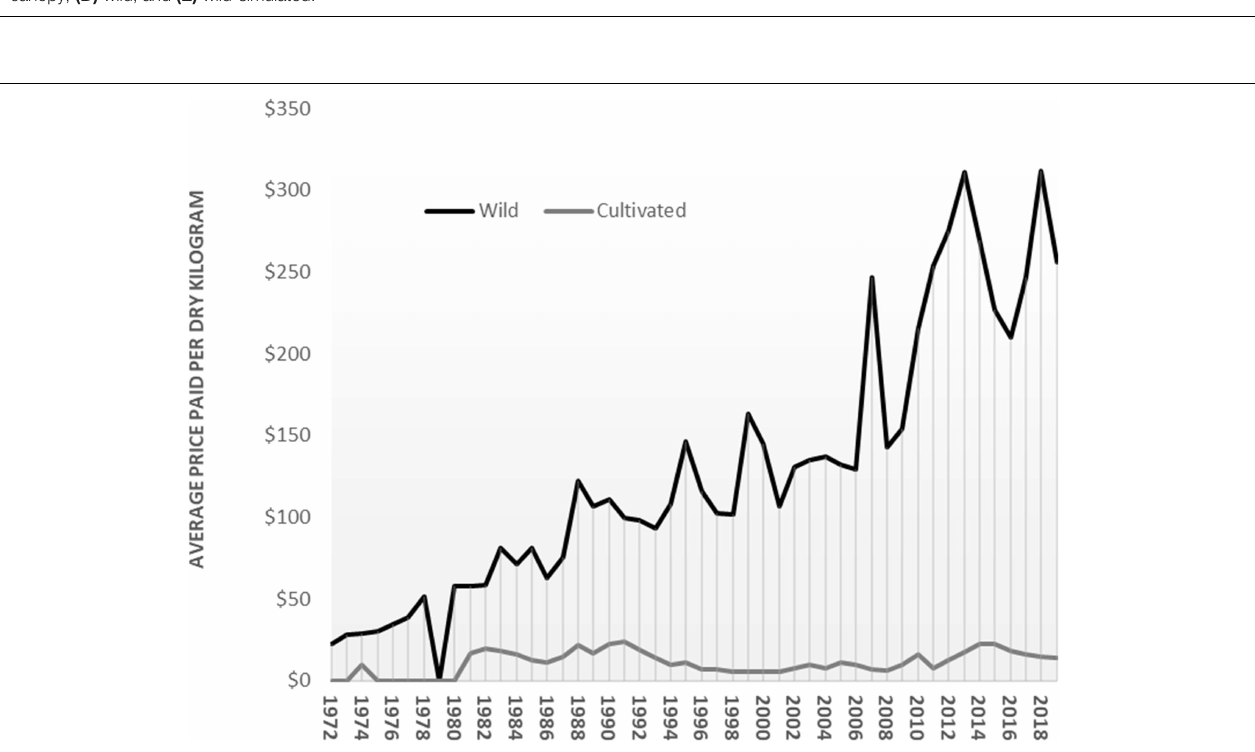
FIGURE 4 | Comparison of the average prices paid for wild versus cultivated American ginseng for the years 1972-2019. (Prices have been sourced from ginseng buyers, producers, publications, and industry experts by EPB).